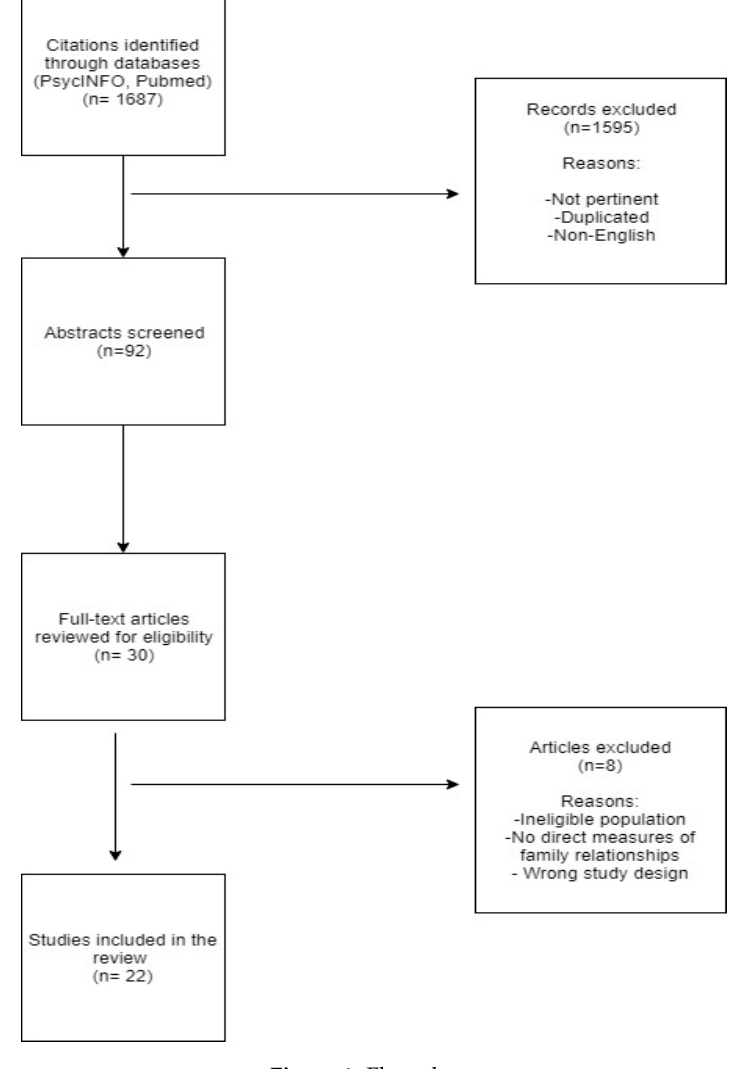
Figure 1. Flow chart.